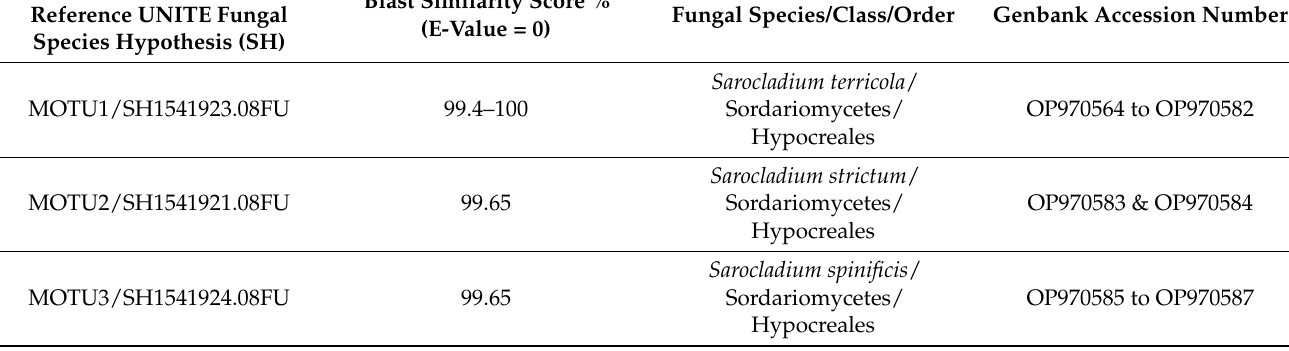
Table 1. List of the MOTUs evidenced in the study with taxonomic assignment provided by UNITE database, respective Blast similarity scores, and associated Genbank accession numbers. In bold are the two MOTUs recovered from ovarioles and ovipositors of L. donacis